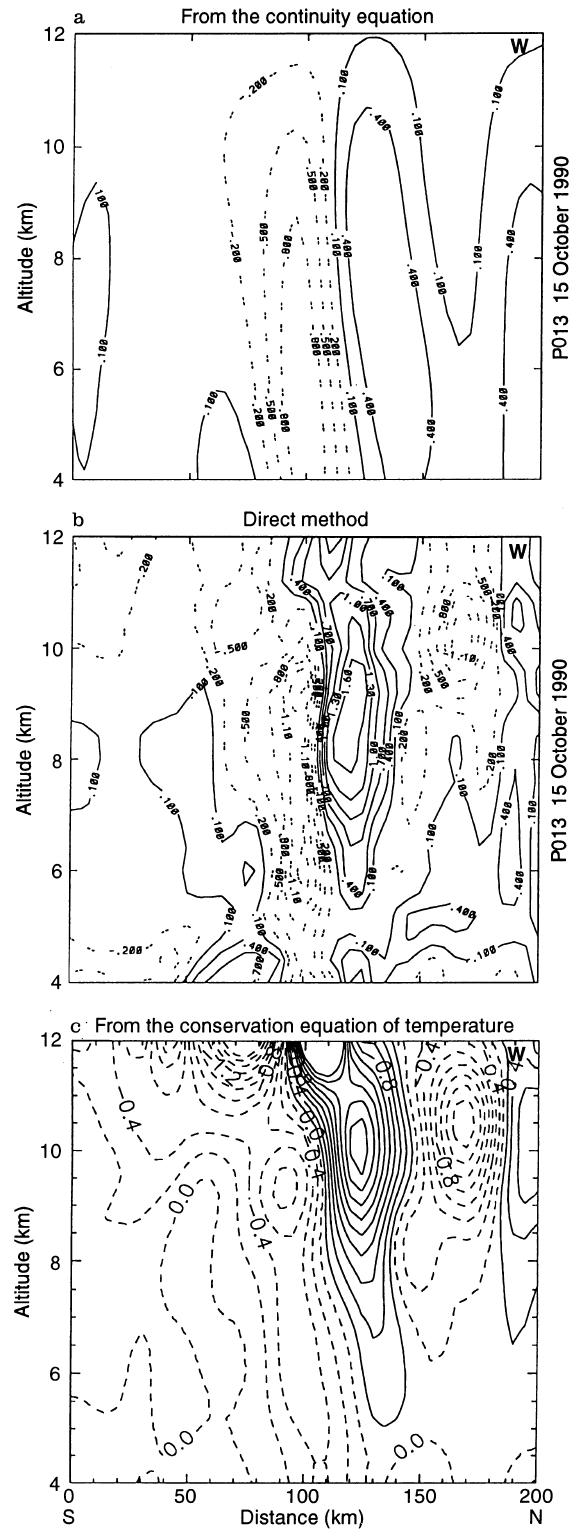
Fig. 18a–c. Vertical velocity of the air (in m s (cid:255) 1 ) computed with a the continuity equation, b with aircraft airspeed and groundspeed vectors and c with the steady-state equation for conservation of the temperature. Solid ( dashed ) lines correspond to upward ( downward ) velocities, example